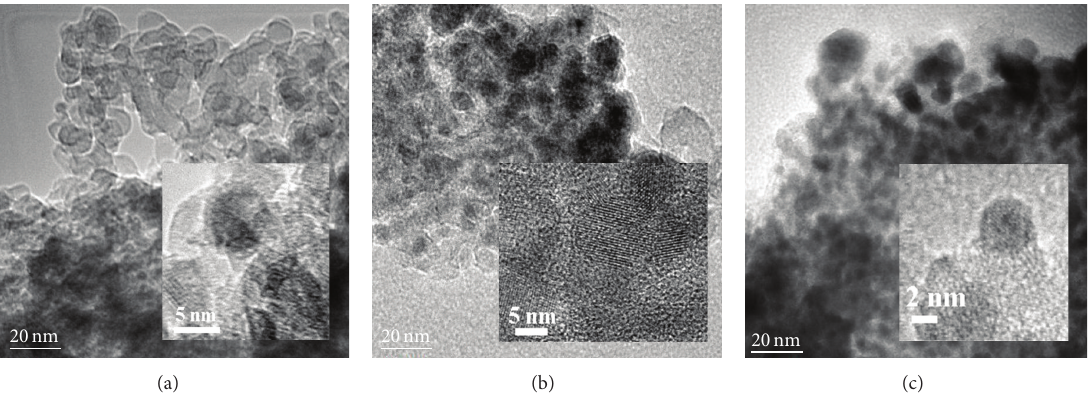
Figure 4: HRTEM micrographs of the three Pd-Pt catalysts prepared by different method. (a) Impregnation, (b) MOCVD, and (c)